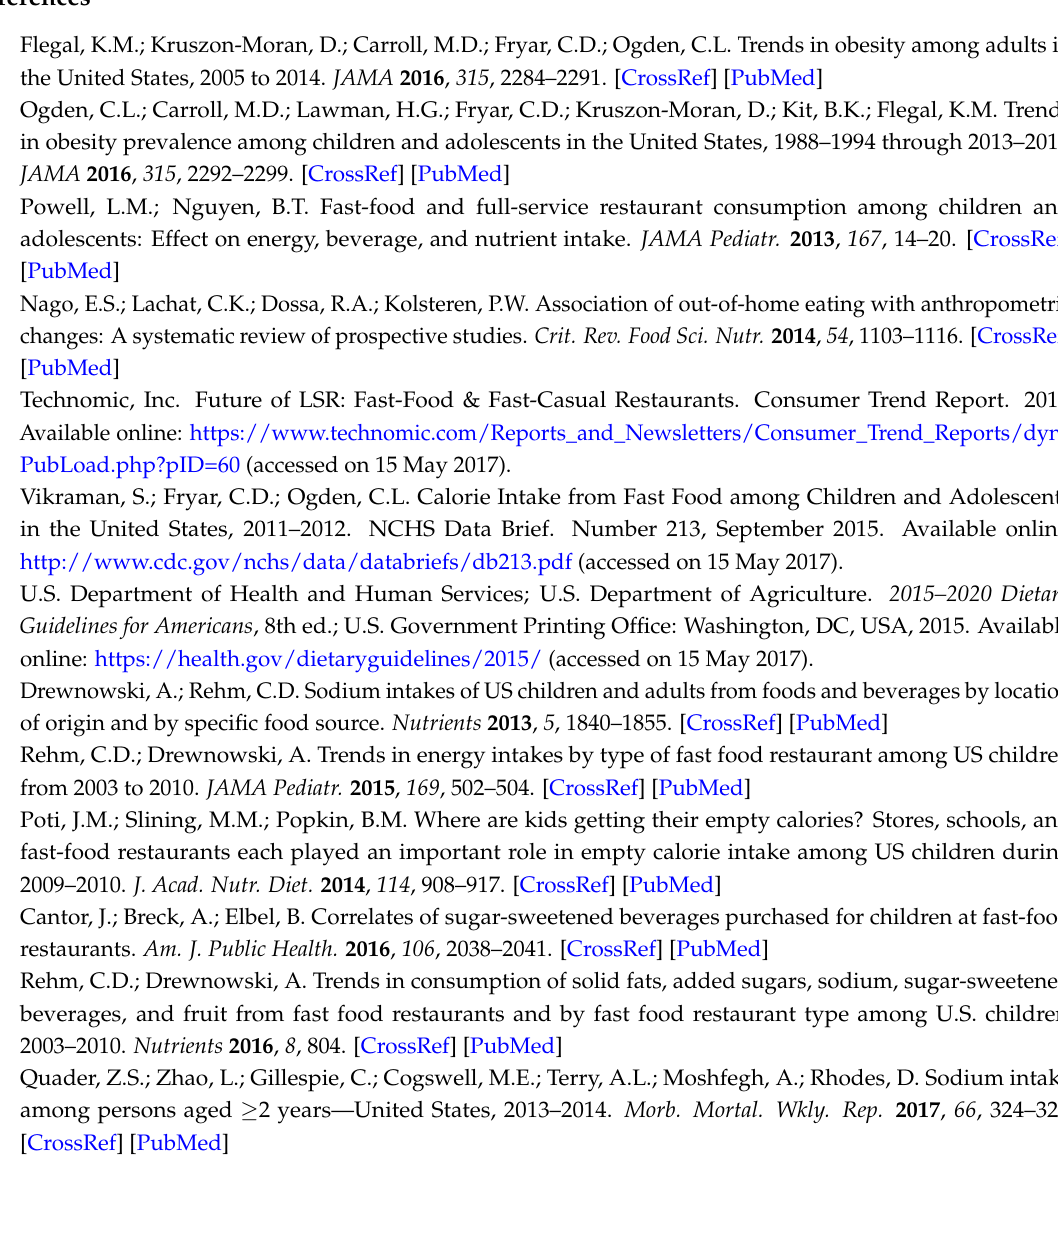
Table S1. Peer-reviewed articles used to evaluate the U.S. restaurant industry (cid:48) s progress to create